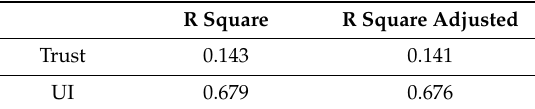
Table 6. Coe ffi cient of determination (R2) values.